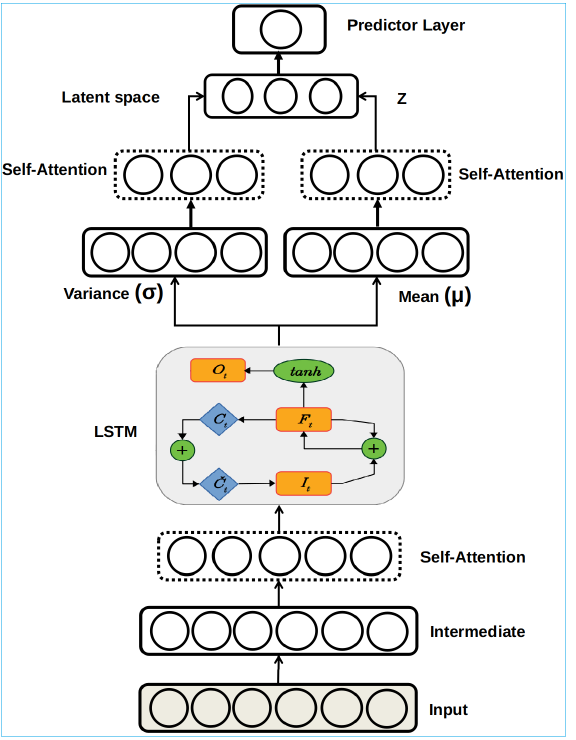
Figure 3. The flowchart of the GAHD-VAE forecasting